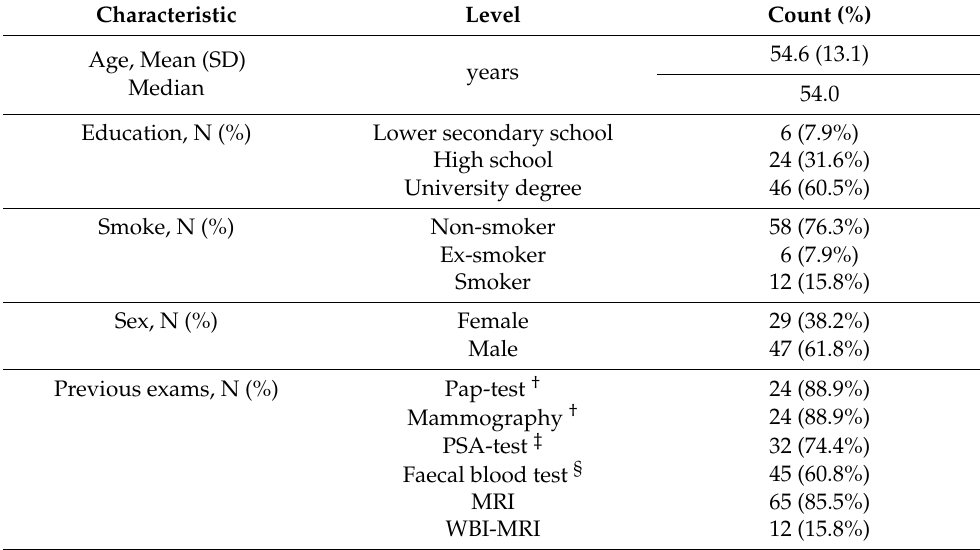
Table 1. Patient’s characteristics, N =